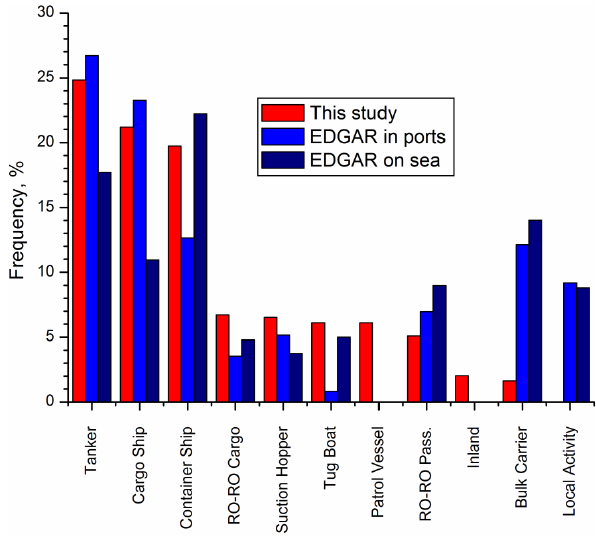
Figure 7. Distribution of the studied ships according to duty, compared with 999 Fig. 7. Distribution of the studied ships according to duty, compared with EDGARv4.2 EDGARv4.2 database. 1000